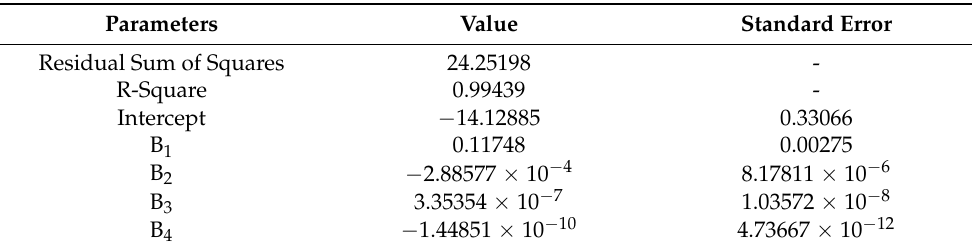
Table 1. The parameters of Equation